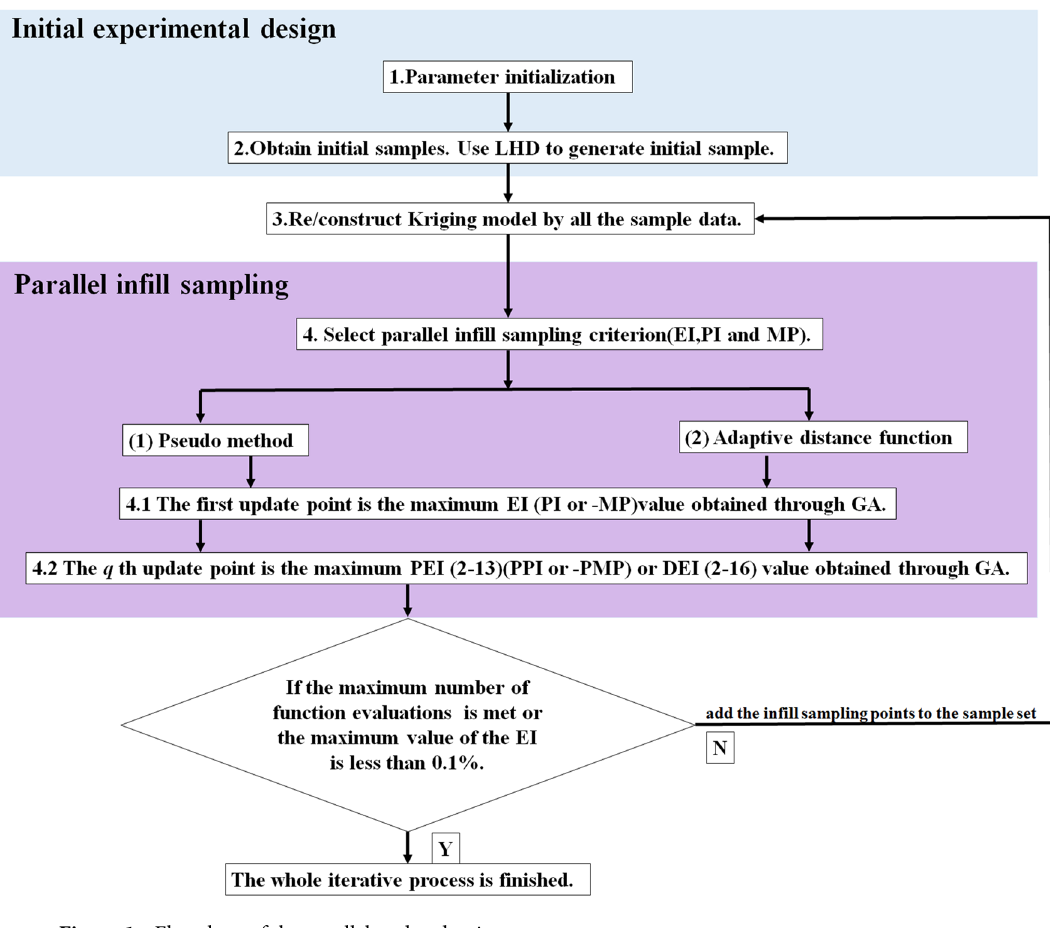
Figure 1. Flowchart of the parallel updated